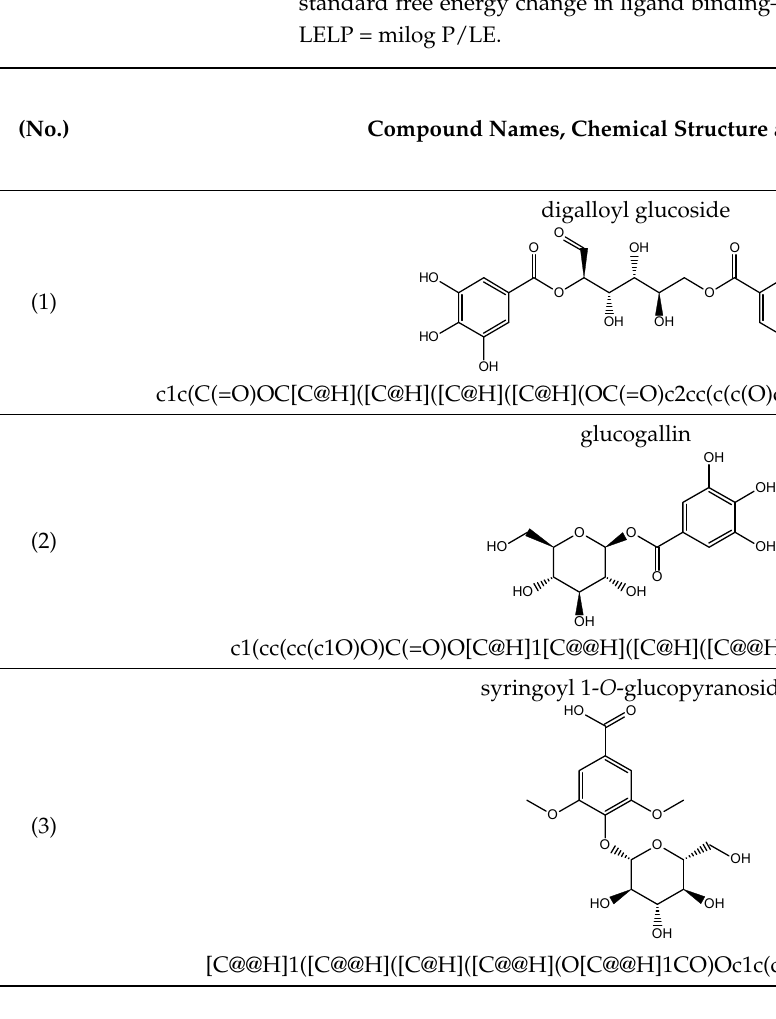
Table 4. Computational analysis of the most abundant compounds found in R. rhaponticum and R. rhabarbarum , native substrate native arachidonic acid and inhibitors: indomethacin and NDGA: MW—predicted molecular weight, PSA—molecular polar surface area, HA—the number of heavy atoms, MBS PI—protease